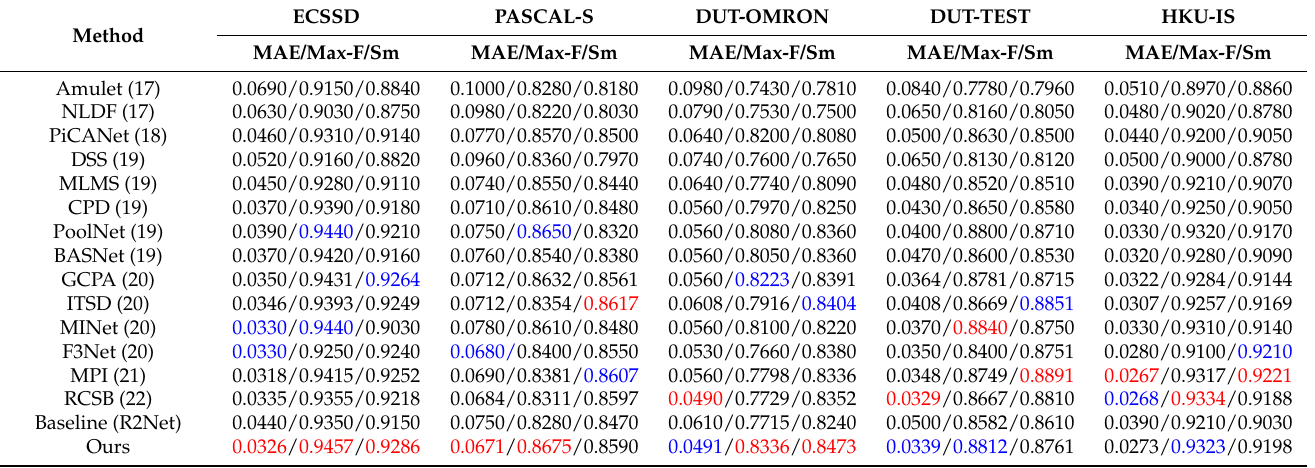
Table 1. The MAE, Max-F, Sm of 15 methods on 5 datasets. The top two results are in red and